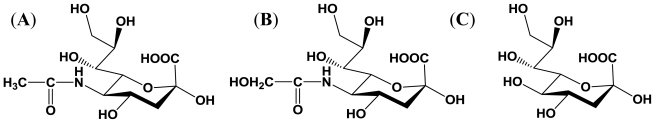
Structures of major three sialic acids. (A) N-acetylneuraminic acid (Neu5Ac); (B) N-glycolylneuraminic acid (Neu5Gc); (C) 2-keto-3-deoxy-d-glycero-d-galacto-noninic acid (KDN).